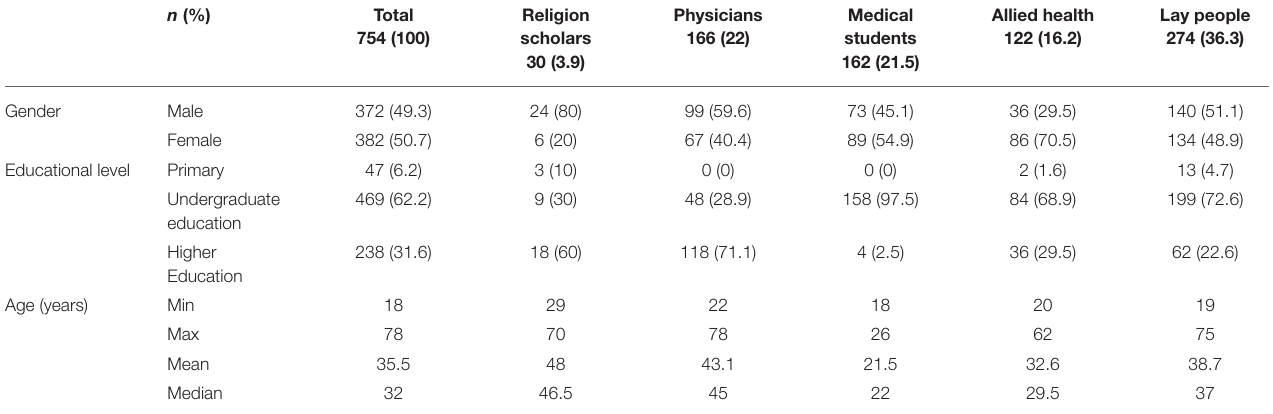
TABLE 1 | Demographics of the study group ( N =